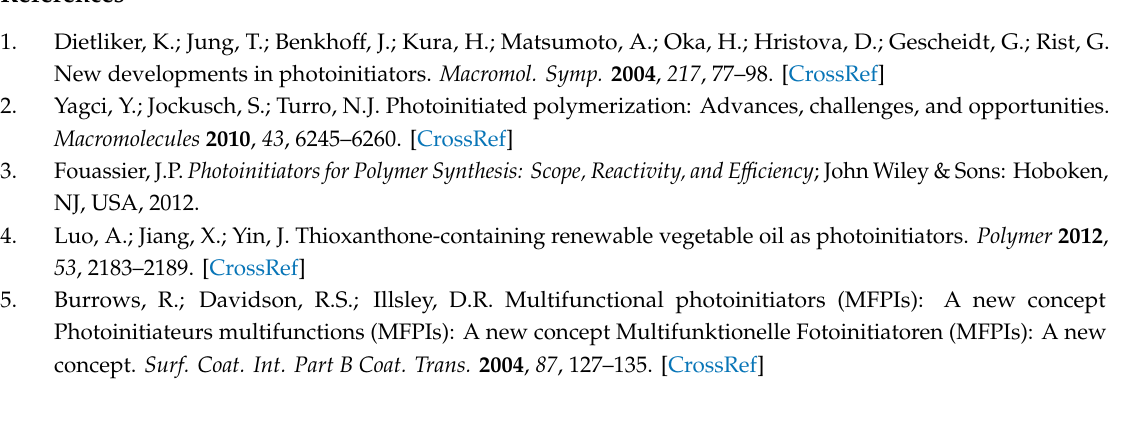
Figure S1: 1 H NMR spectra of PSO-Cl (CDCl 3 ), TX-HB (DMSO) and STX (CDCl 3 ), Figure S2: 13 C NMR spectra of PSO-Cl (CDCl 3 ), TX-HB (DMSO) and STX (CDCl 3 ), Figure S3: FTIR spectra of TX-B and STX, Figure S4: Conversion-time and rate-time for polymerization of TMPTA in THF (THF % = 25 wt%) in laminate initiated